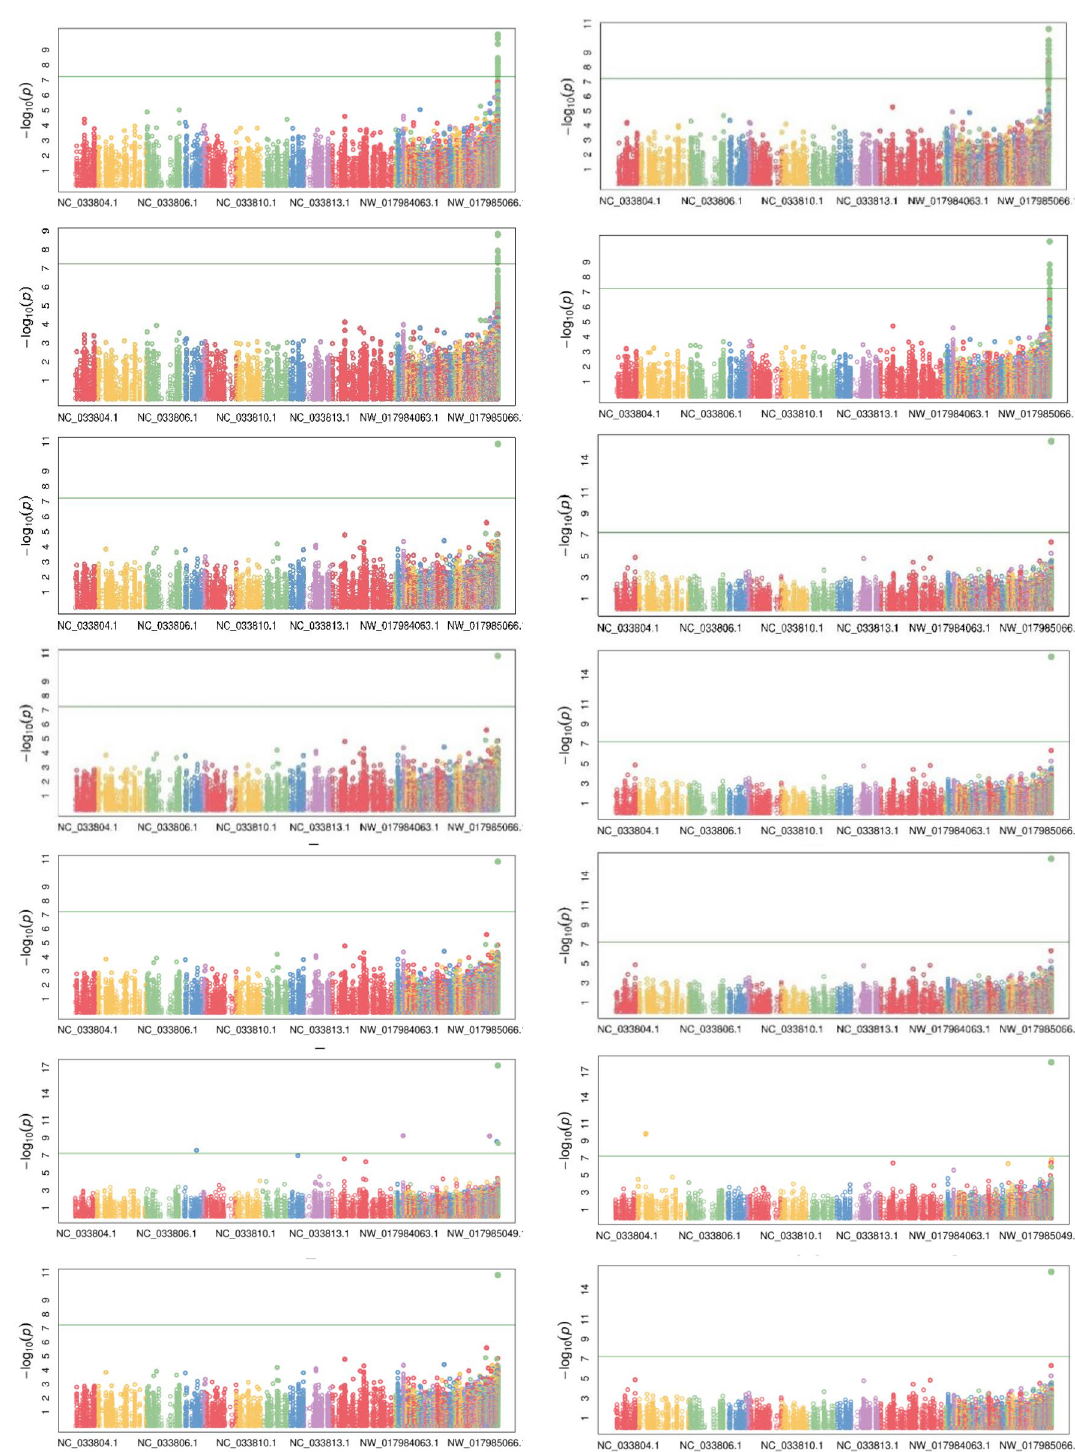
Figure 3. Manhattan plots for DOF (Left side) and DFF (Right side) for the year 2017–18. Top to bottom order is GLM, MLM, MLMM, CMLM, ECMLM, FarmCPU and